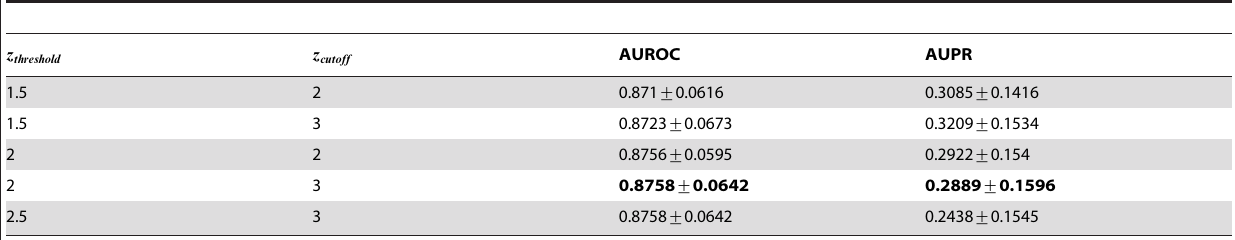
Table 7. Effects of z cutoff and z threshold on AUROC and AUPR of TRaCE in DREAM4 100-gene subchallenge: single gene KO data.